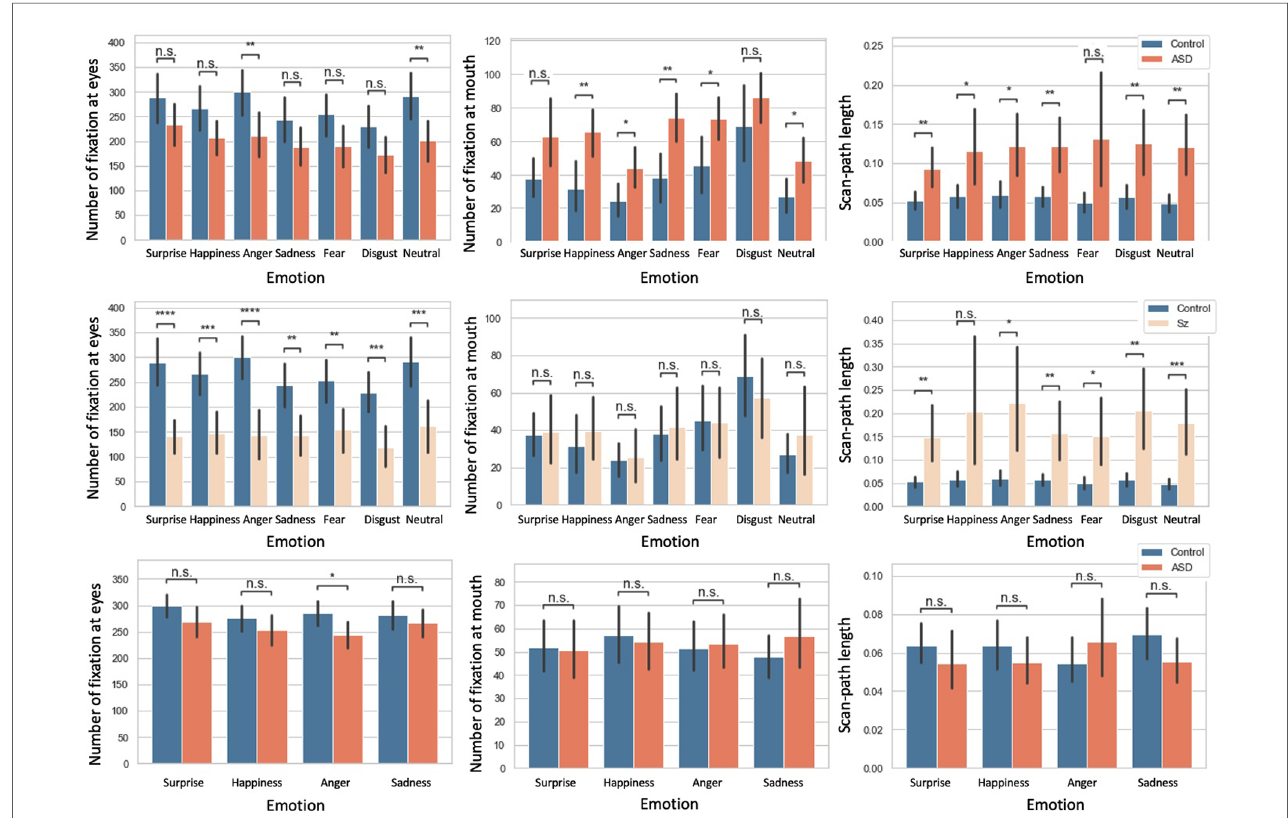
FIGURE 4 First row: comparison of ASD vs. control groups in adults; Second row: comparison of Sz vs. controls in adults. Third row: comparison of ASD vs. controls in children. The error bar denotes the size of the con fi dence intervals (95%), n.s.: no signi fi cance, *: p , 0 : 05, **: p , 0 : 01, ***: p , 0 : 001, ****: p , 0 :